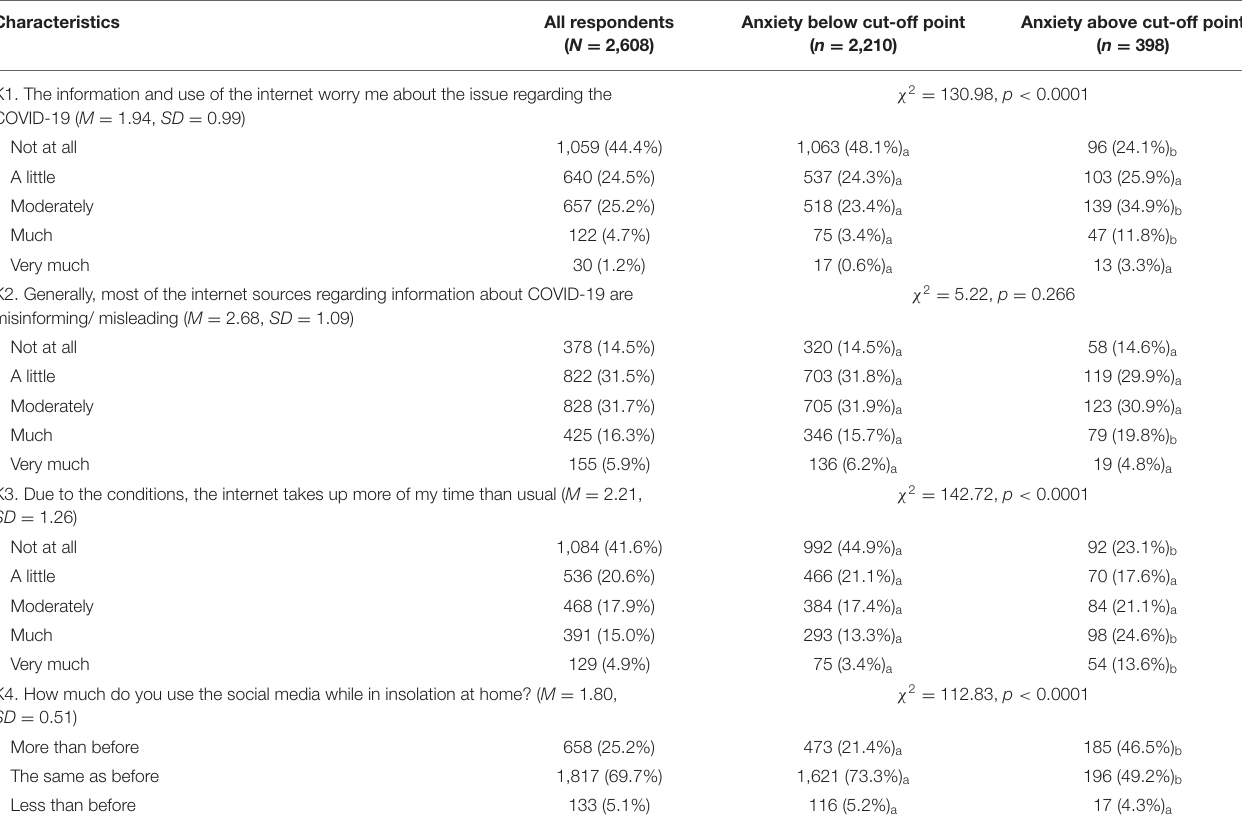
TABLE 5 | The association of anxiety and Internet use characteristics in the general population of Latvia during the COVID-19 state of emergency ( n = 2,608).